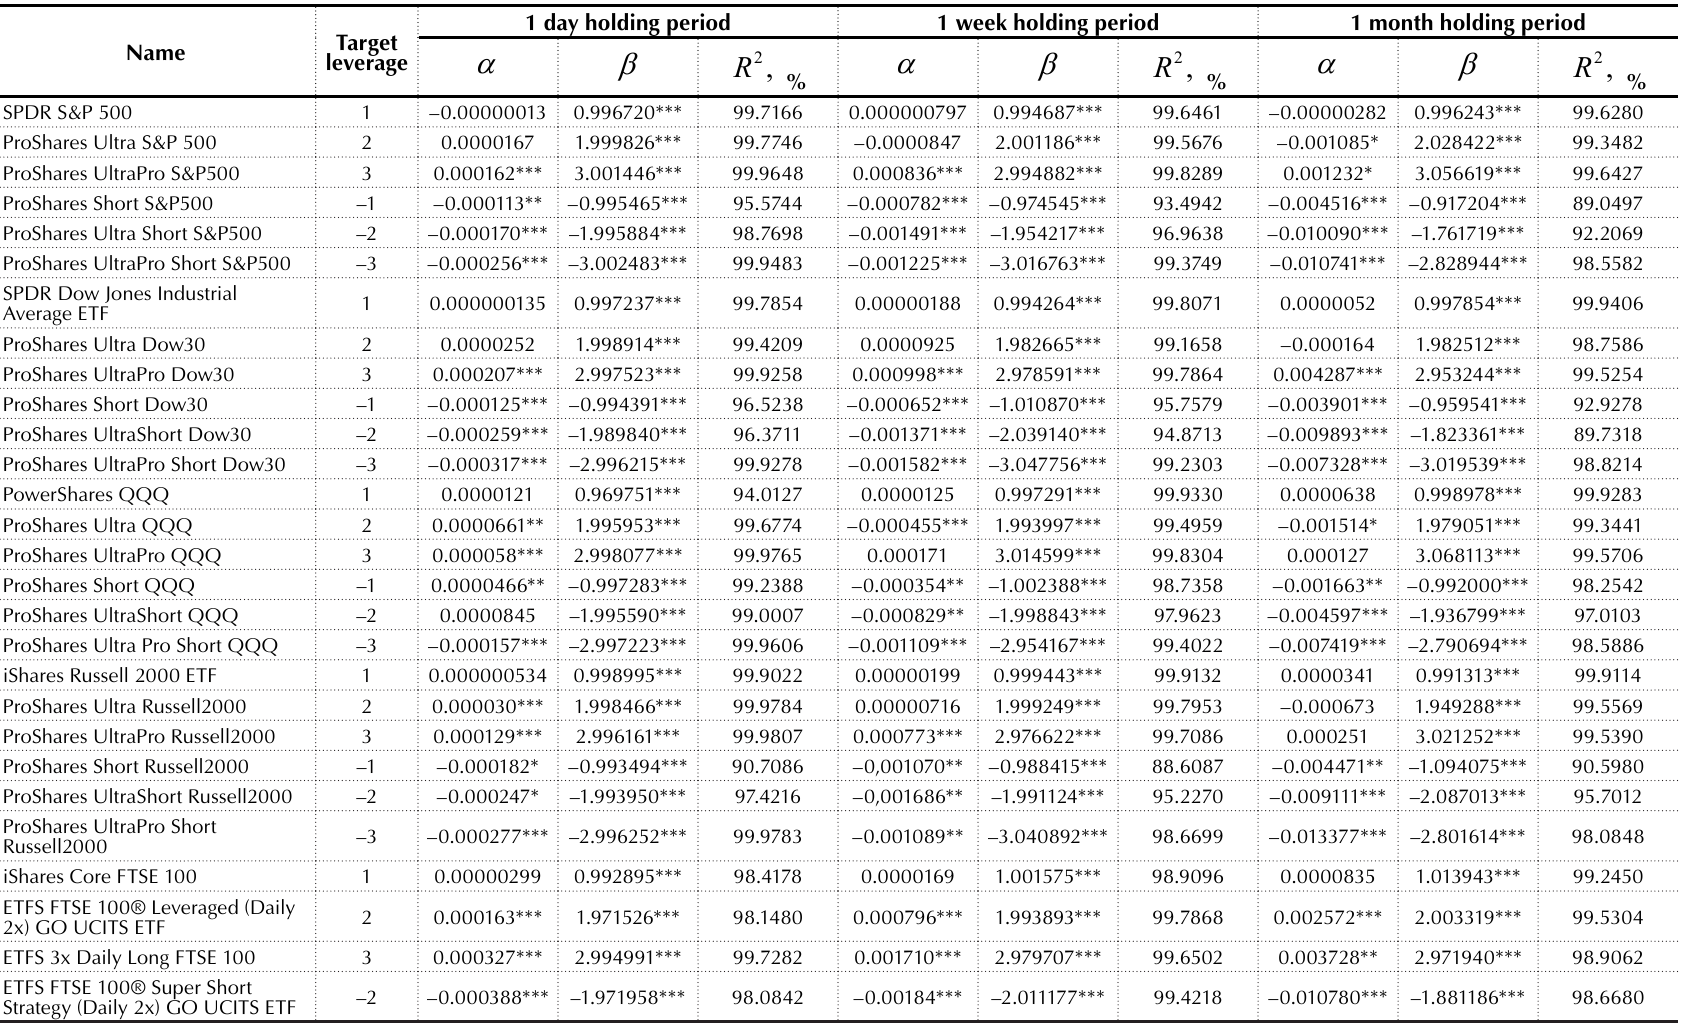
Table 4. Regression analysis from ETF inception to April 28, 2017 during different holding periods